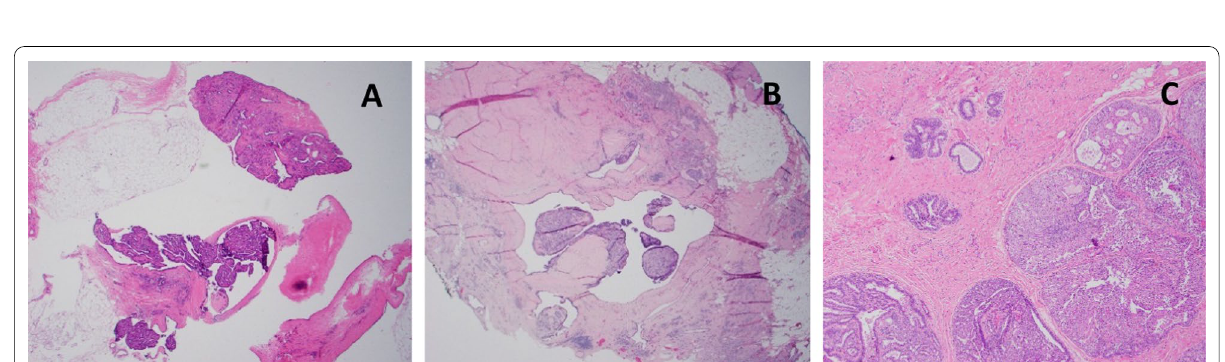
Fig. 4 Photomicrograph shows fragments of a sclerosing intraductal papilloma, hematoxylin and eosin, total magnification 20 biopsy demonstrated residual intraductal papilloma, total magnification 20 identified in the breast tissue adjacent to, but not involving the papilloma, spanning 10 mm ( C